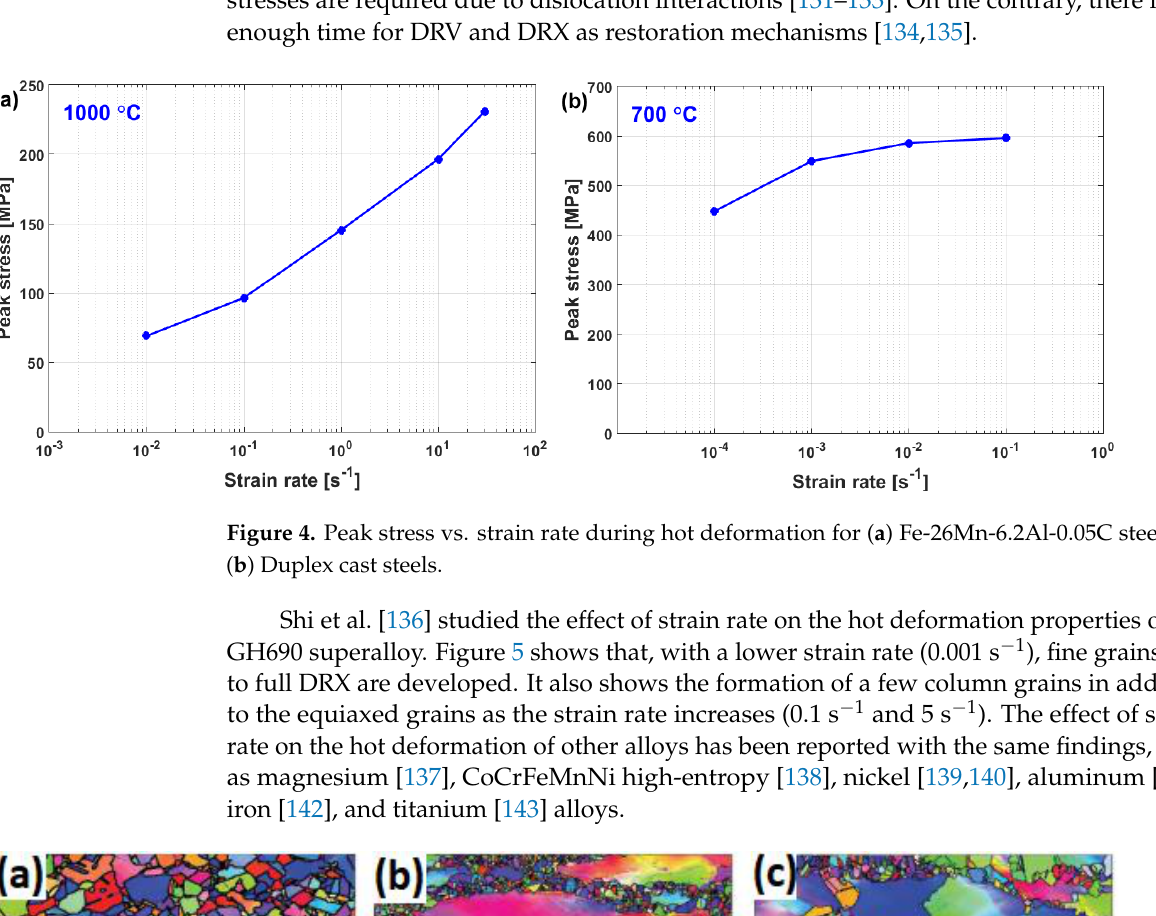
Figure 6. Peak stress vs. temperature during hot deformation for ( a ) Fe-26Mn-6.2Al-0.05C steel and ( b ) Duplex cast steel. Song et al. [153] studied the effect of hot deformation and DRX on a new Ni – Cr – Co nickel-based superalloy. Figure 7 shows that increasing the temperature leads to the formation of fine grains. Elongated grains can be seen in Figure 7a, passing with DRX at grain boundaries in Figure 7b and, finally, complete DRX and the growth of fine grains, as in Figure 7c. The effect of temperature on different alloys has been noticed with the same findings, such as nickel [154,155], Al-Cu-Mg [156], titanium [157] Ni – Co [158], and aluminum [159] alloys.